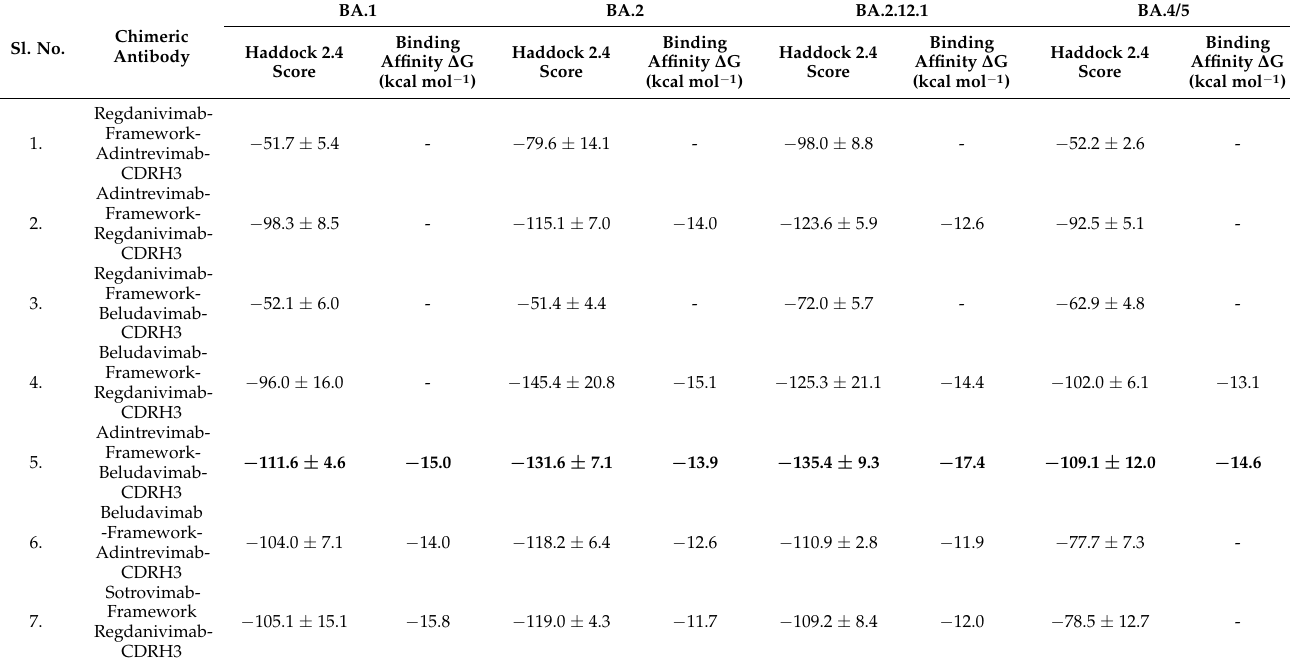
Table 5. Affinity of chimeric mAbs against spike protein of omicron variants BA.1, BA.2, BA.2.12.1, and BA.4/5 of